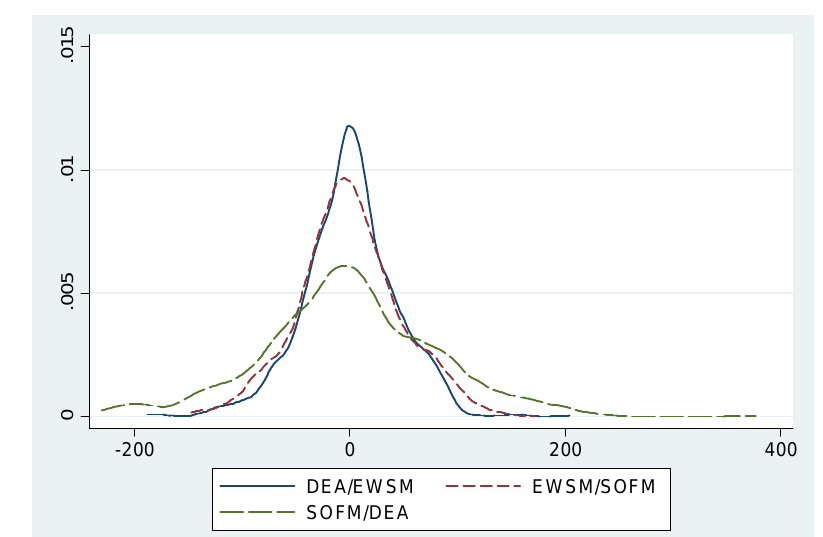
Figure 1 - Shift in the individuals’